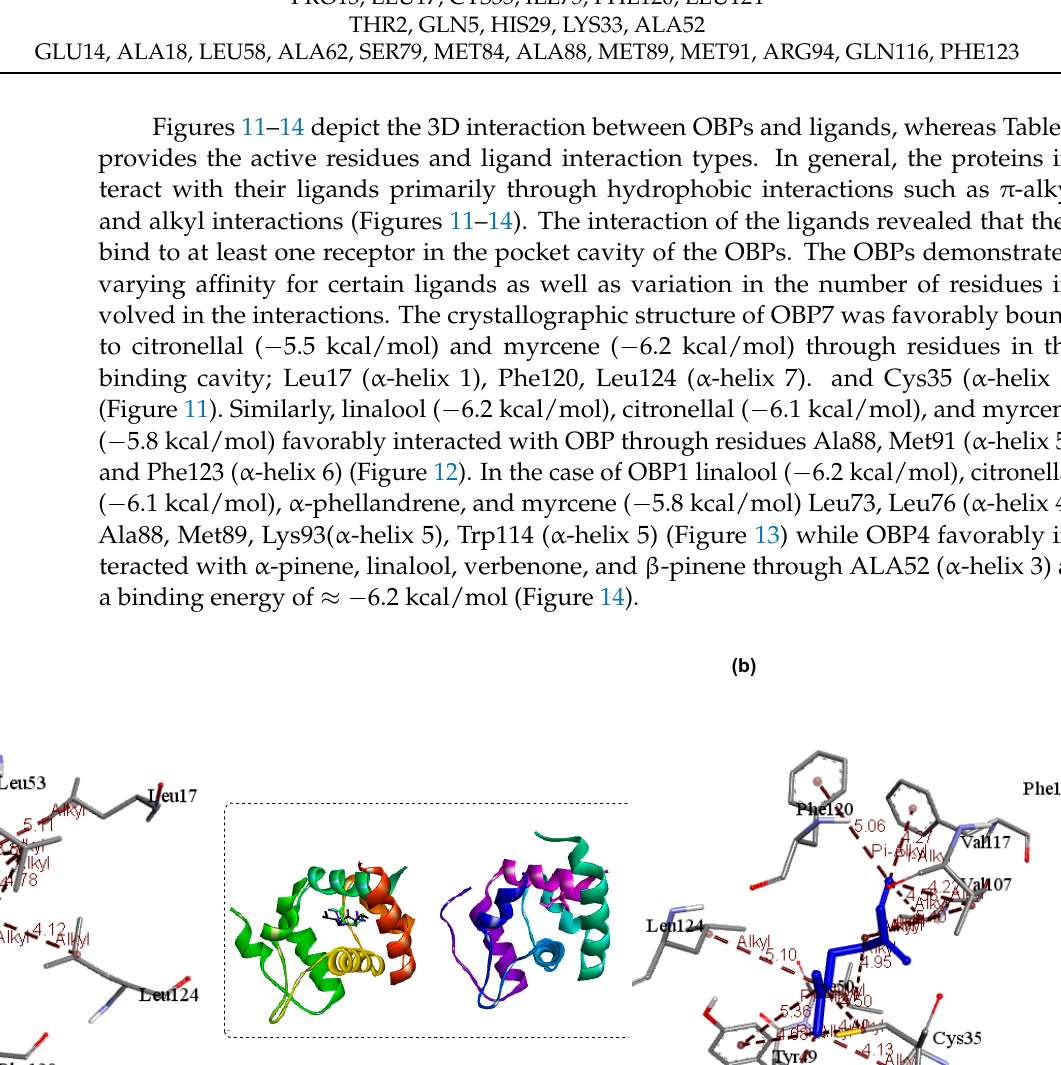
Table 7. The number and type of bonds for the OBD–ligand complexes.